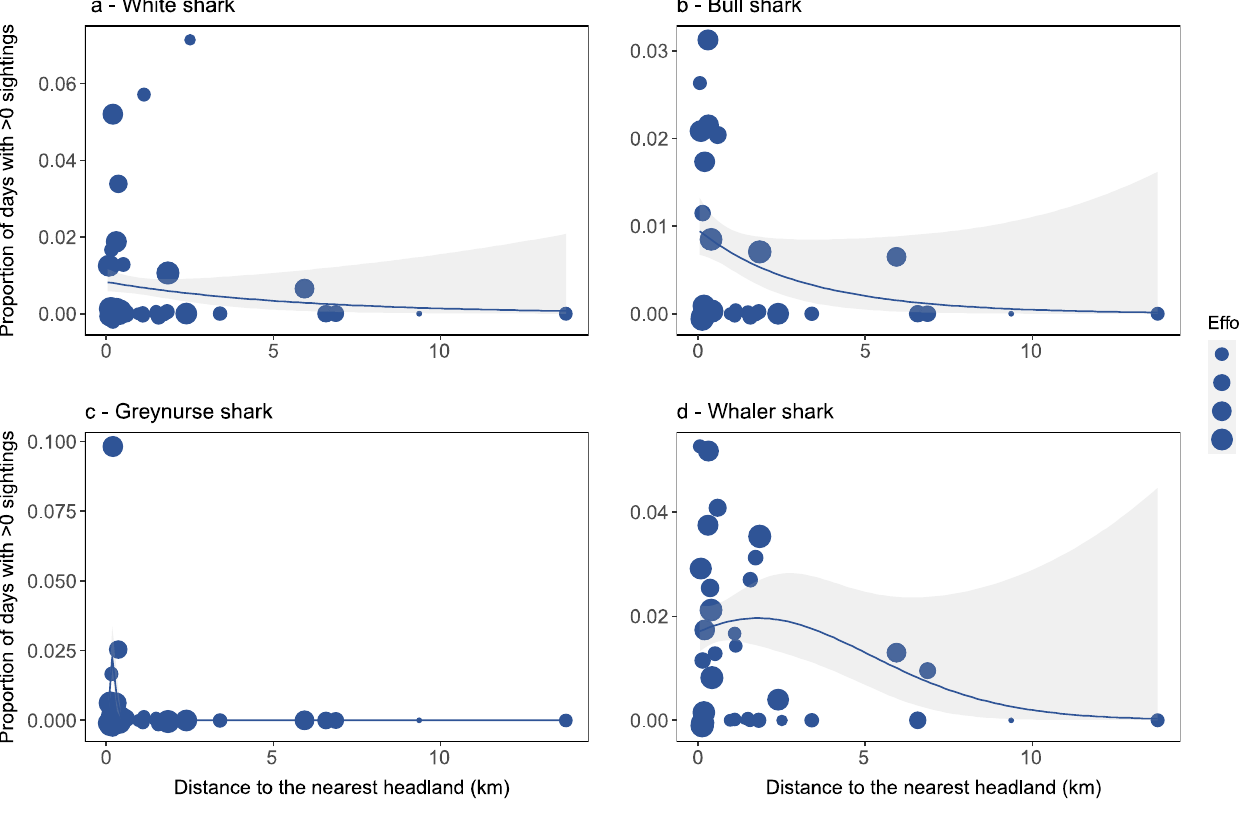
Figure 3. Detection rates for each beach location in relation to distance to the nearest headland for ( a ) white shark, ( b ) bull shark, ( c ) greynurse shark, and ( d ) whaler shark species, and estimated response curves with a 95% confidence region. Points are sized proportionally to the total flight effort at each location proportional to the average effort. Thus, a weight of 1.0 equals average flight effort, <1 equals below average effort, and >1 equals above average effort.